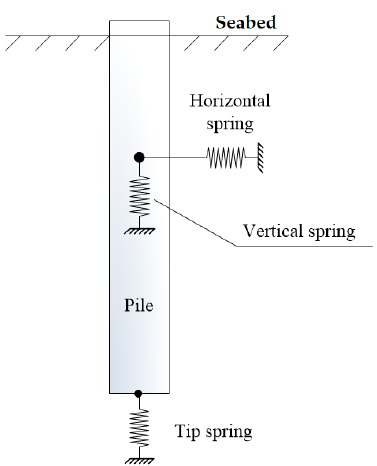
Figure 5. Soil idealization model with soil translational nonlinear springs. J. Mar. Sci. Eng. 2020 , 8 , x FOR PEER REVIEW